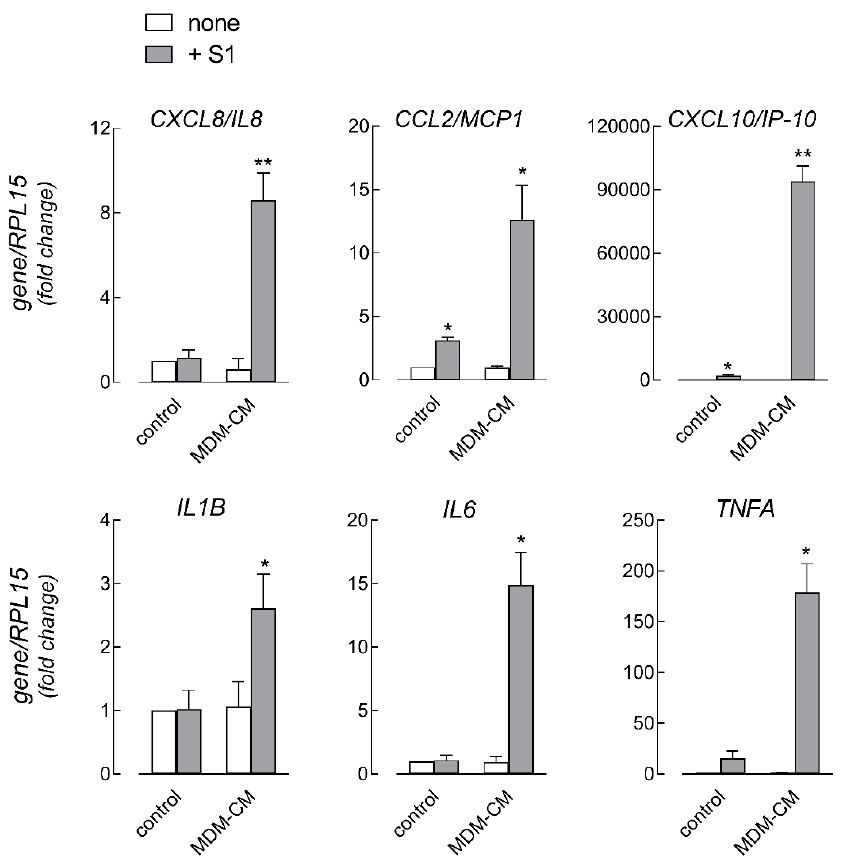
Figure 6. HLMVEC were incubated for 6 h in fresh RPMI1640 (control) or in MDM-conditioned medium (MDM-CM), as described in Figure 5. The expression of the indicated genes was then measured by means of RT-qPCR, normalized for that of the housekeeping gene RPL15, and expressed relative to none in control cells (=1). Data are means ± SEM of three experiments, each performed in duplicate. * p < 0.05, ** p < 0.01 vs. none in control with “one-sample t -test”.